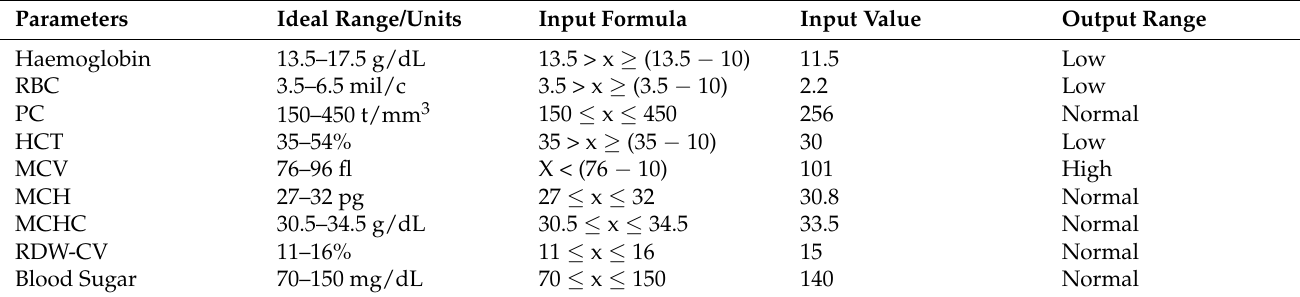
Table 9. Patient Blood Report 2.